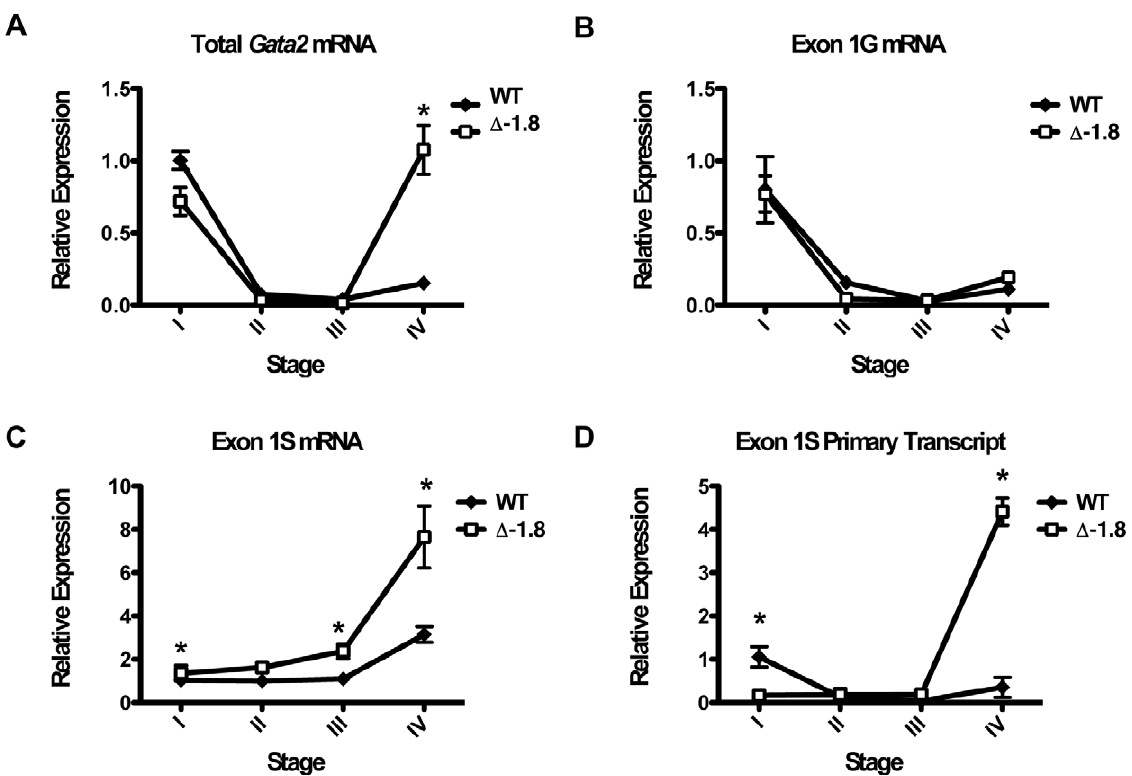
Figure 5. Promoter usage in D -1.8 Gata2 dysregulation. Total Gata2 mRNA (A), mRNA selectively arising from the 1G (B) or the 1S (C) promoter, and primary, unspliced transcript arising from the 1S promoter (D) in Stage I through Stage IV sorted erythroid cells from wild-type and D -1.8 embryos at E14.5.